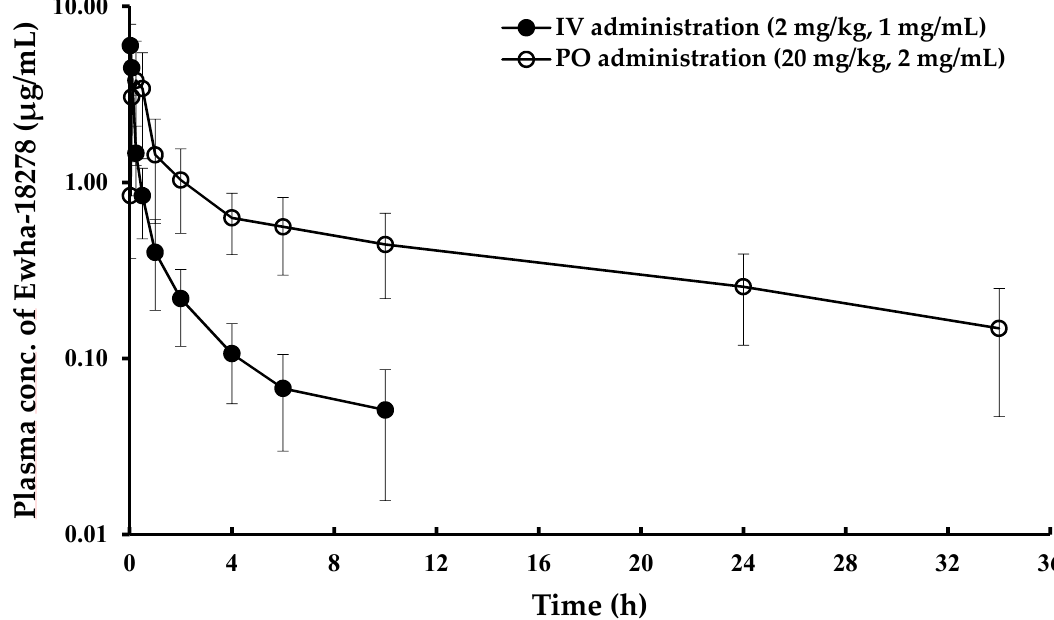
Figure 2. Mean plasma concentration-time profiles of Ewha-18278 in DMSO-based formulation after IV and oral administrations to rats. ● , IV administration (2 mg/kg); ○ , oral administration (20 mg/kg). Error bars represent S.D. ( n = 6).